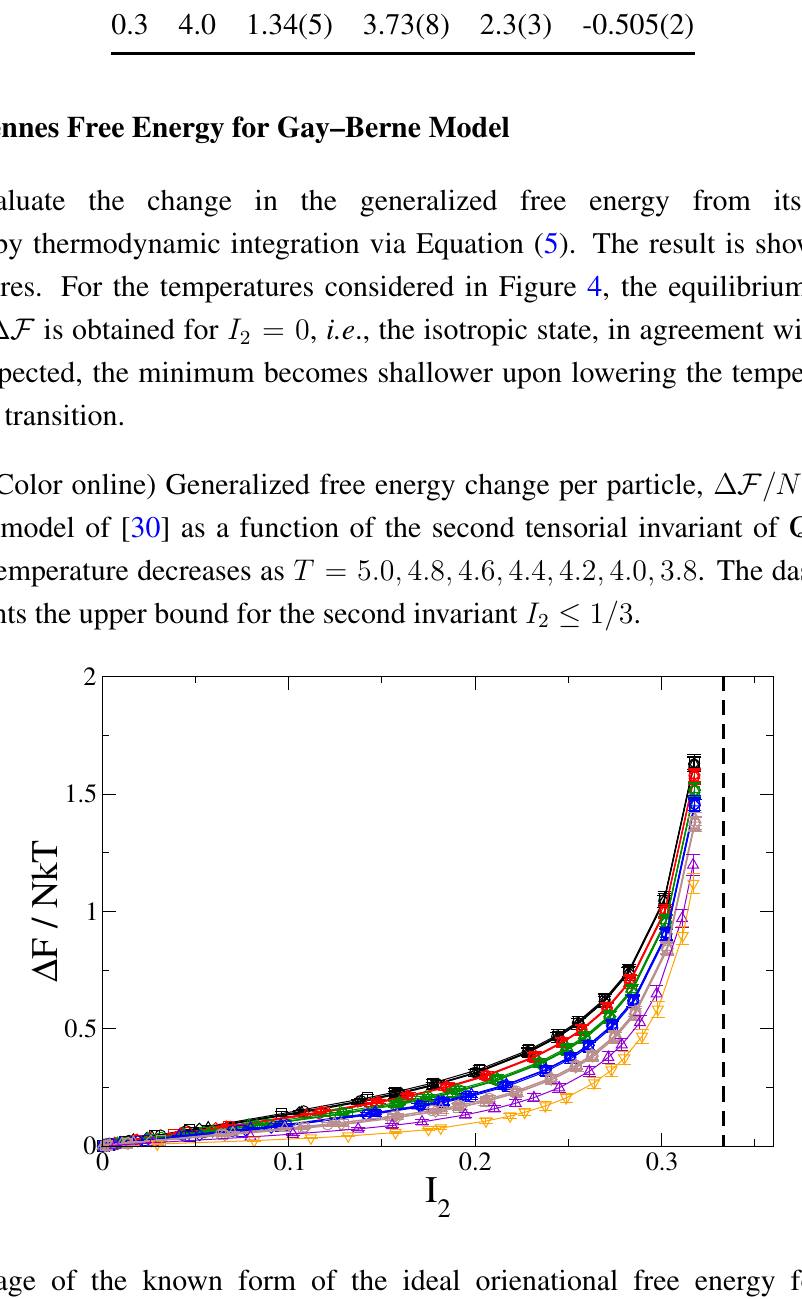
Figure 4. (Color online) Generalized free energy change per particle, ∆ F /Nk Gay–Berne model of [30] as a function of the second tensorial invariant of Q . From top to bottom, temperature decreases as T = 5 . 0 , 4 . 8 , 4 . 6 , 4 . 4 , 4 . 2 , 4 . 0 , 3 . 8 . The dashed vertical line represents the upper bound for the second invariant I